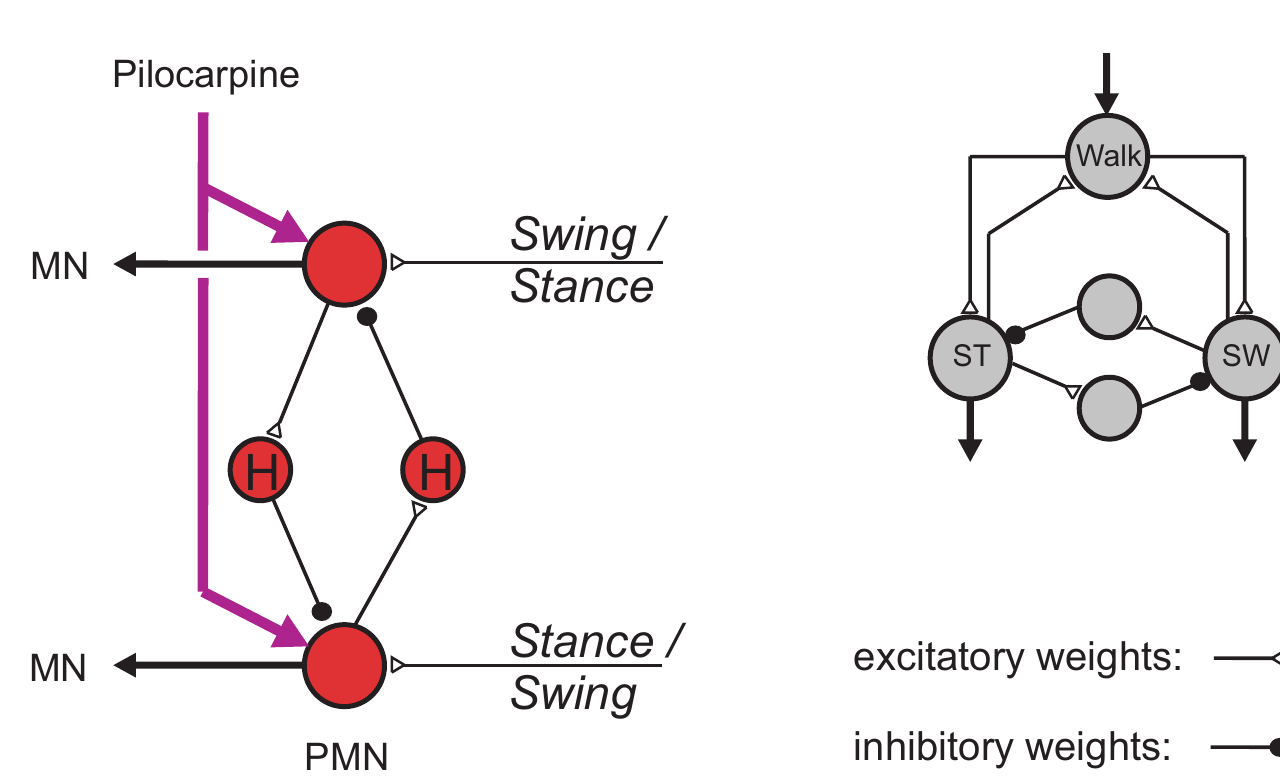
Fig 5. Two similar, distinct networks that are elements of units shown in Fig 1A. Left: Four units (red) form a PMN network. Both inhibitory units are equipped with a high-pass filter (H). The purple arrows represent external injection of pilocarpine. Right: four units (grey), two of which are recurrently connected with unit Walk via constant input. Both inhibitory units do not have high-pass properties, but only low-pass filter properties as is the case for all other neurons in neuroWalknet.